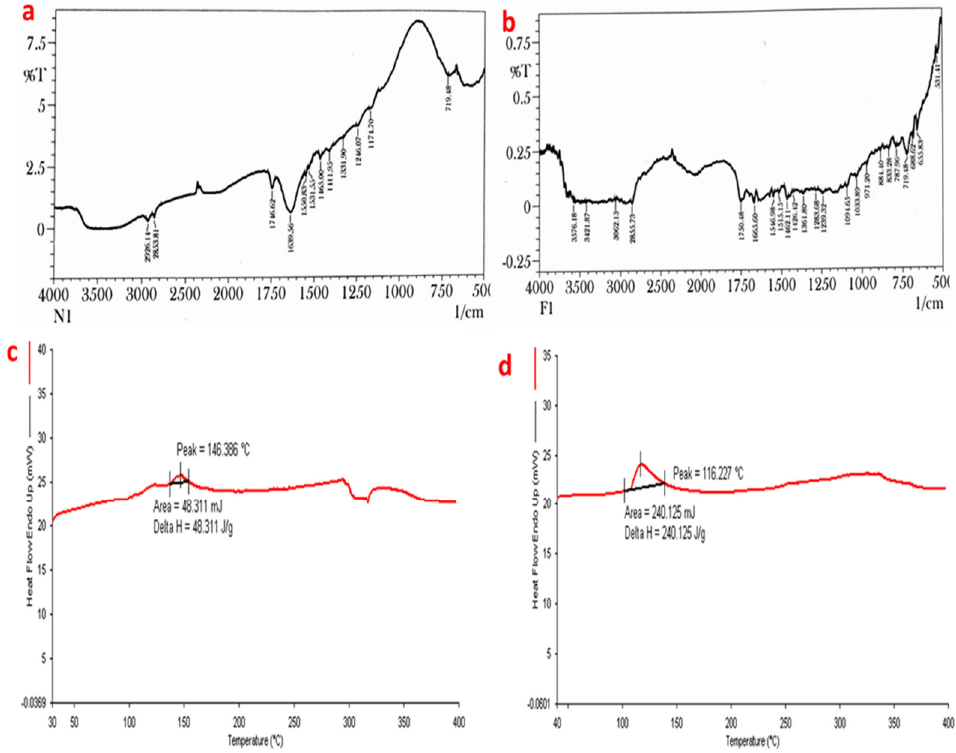
Figure 7. Skin permeation enhancement study evaluated using FTIR and DSC: ( a ) FTIR of normal skin and ( b ) Hsp-PAMAM-treated skin. ( c ) DSC of normal skin and ( d ) Hsp-PAMAM treated skin.